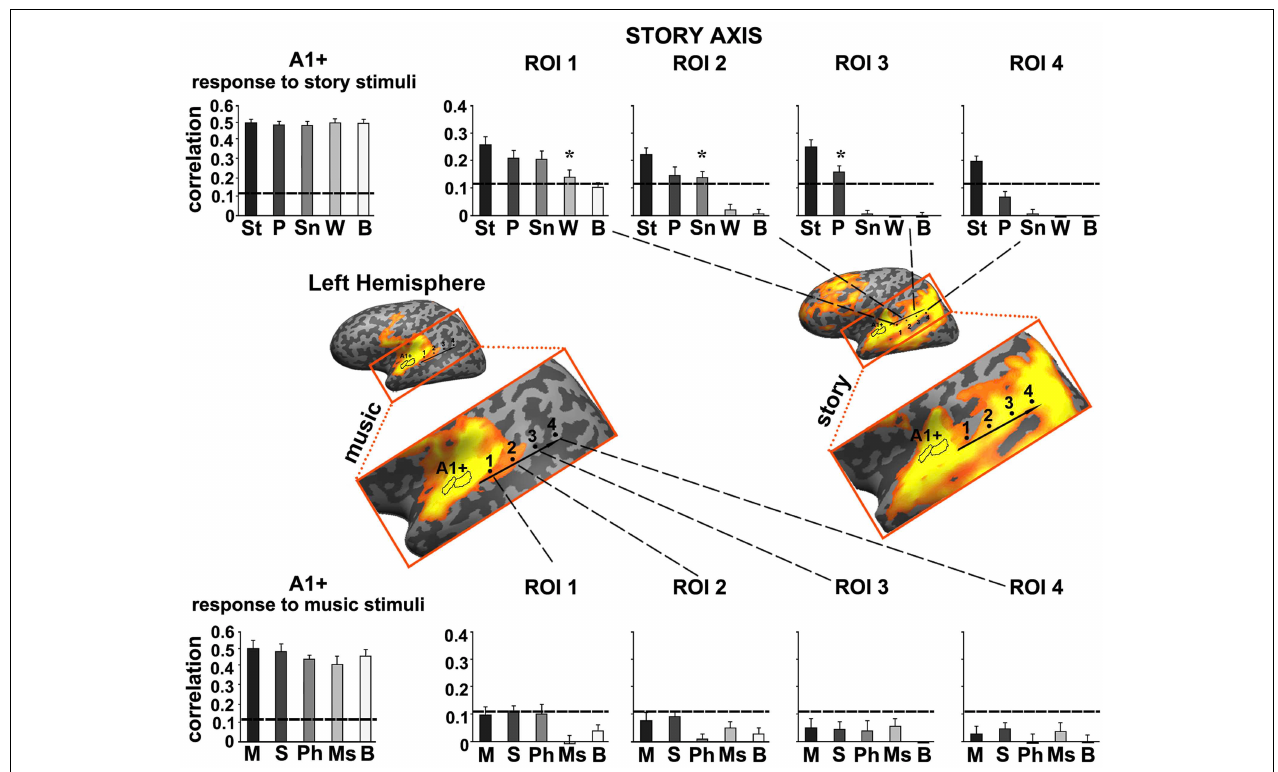
story stimuli. Inter-SC is plotted for each of the story stimuli, scrambled at each of several timescales, for each of the ROIs. Horizontal lines indicate thresholds for statistically significant correlations assessed using phase-randomization and false discovery rate procedures (see Methods). Asterisks denote significant differences between reliable responses to scrambled conditions vs. intact condition; * p < 0 . 05 , one-tailed, paired t -test. Bottom row, response reliability to music stimuli. Error bars indicate estimated standard